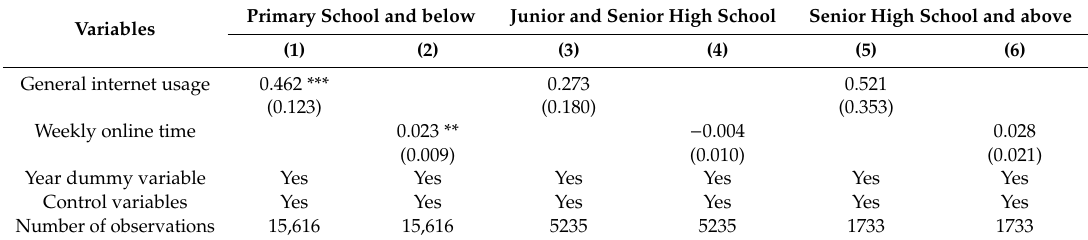
Table 6. Impact of internet use on health outcomes of rural adults with different educational backgrounds.